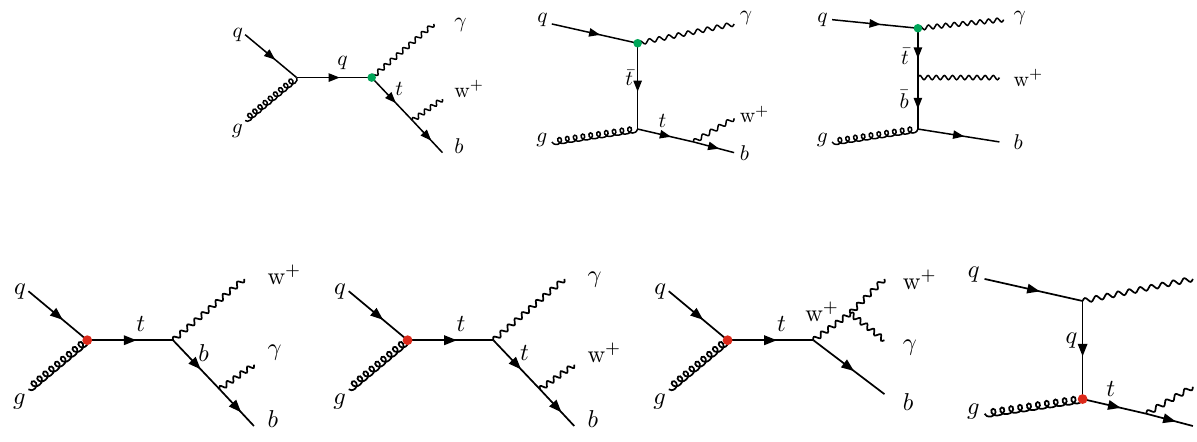
Fig. 1 The Feynman diagrams of pp → Wb γ process containing anomalous FCNC tq γ (green dot) and tqg (red dot)